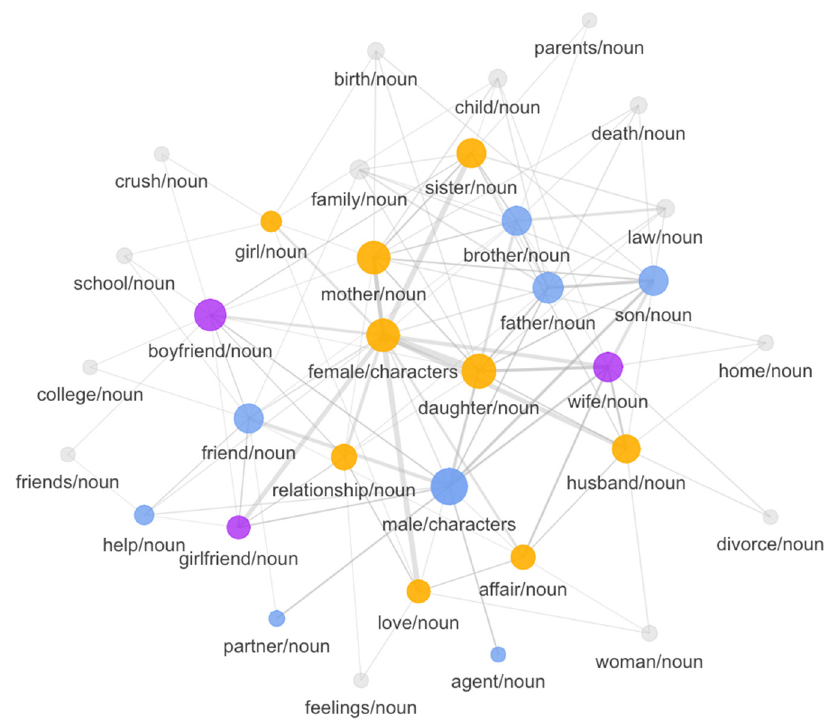
Figure 7. Most significant primary noun associations with males and females. Nouns found to strongly co-occur with female characters included ‘daughter’ and ‘mother’; for male characters, they included ‘friend’ and ‘father’. Nouns such as ‘boyfriend’, ‘wife’, and ‘girlfriend’ co-occurred strongly with both female and male characters.